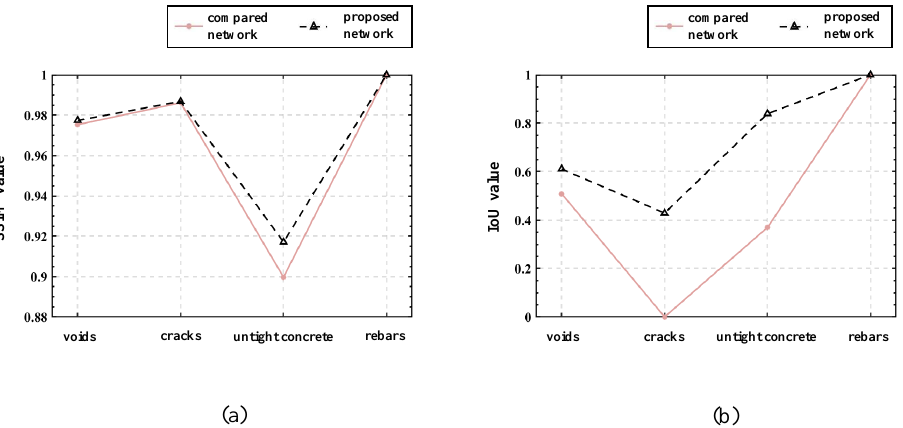
Figure 8. The SSIM and IoU of the proposed network and compared network: ( a ) SSIM value, ( b ) IoU